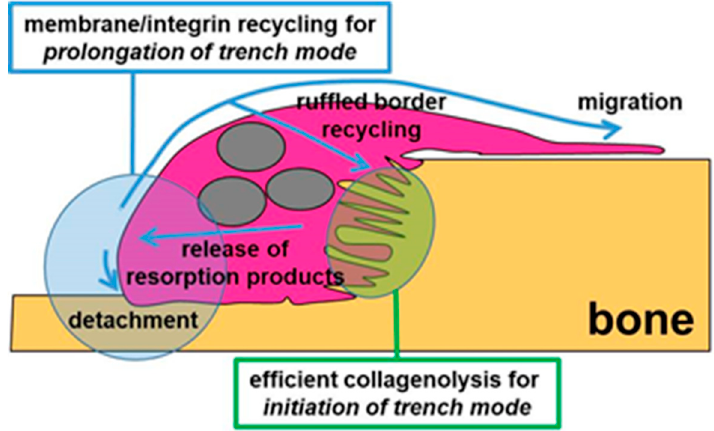
Figure 8. Model illustrating the unique features of the trench resorption mode demonstrated in the present study. Grey symbols represent three nuclei. Please refer to Discussion for further details.